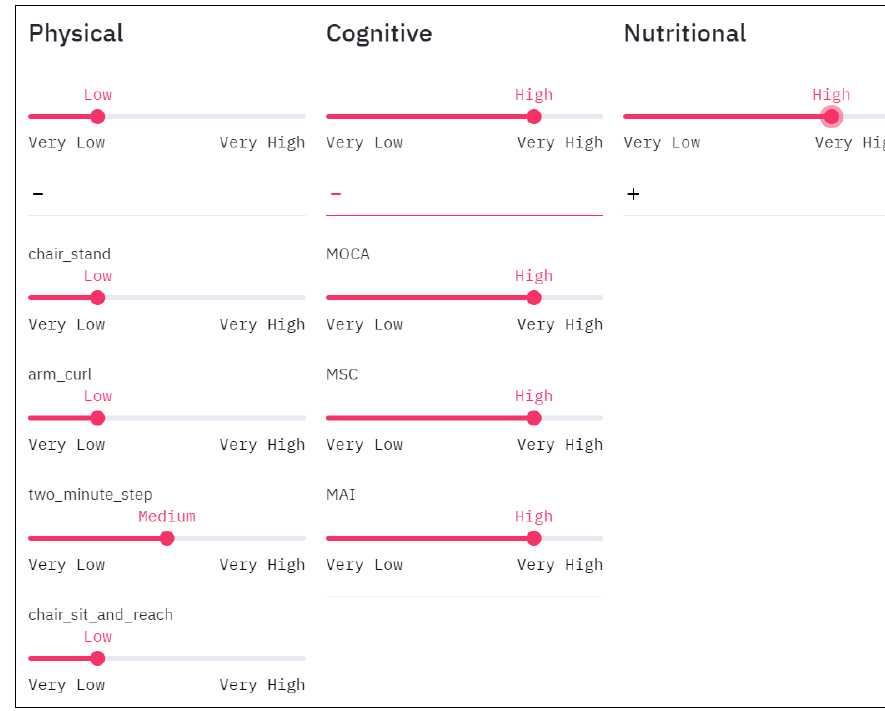
Figure 1. Sliders to specify different weights (importance) to variables for distance calculation.